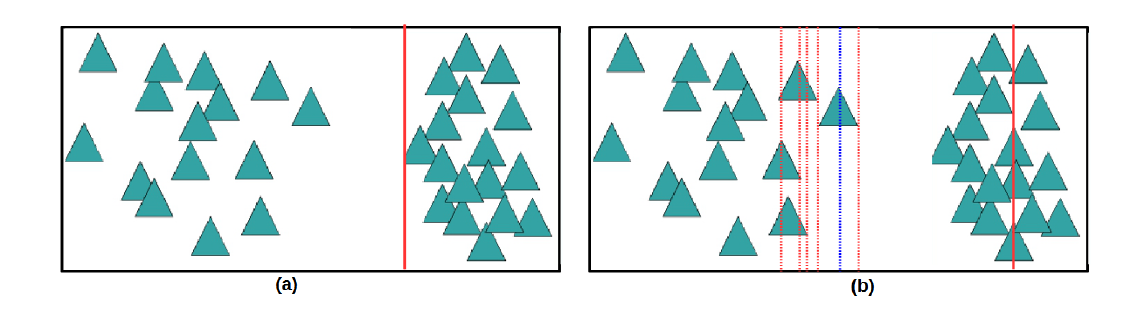
Figure 3. Two ways, ( a , b ), of splitting a space containing triangles by a subspace, here indicated by a red bold line. Split ( a ) is more efficient. The red dashed lines in ( b ) indicate examples of candidate splitting planes. The blue dashes line in ( b ) indicates a wrong candidate plane as the efficiency of this split is worse than that of each of the adjacent splitting